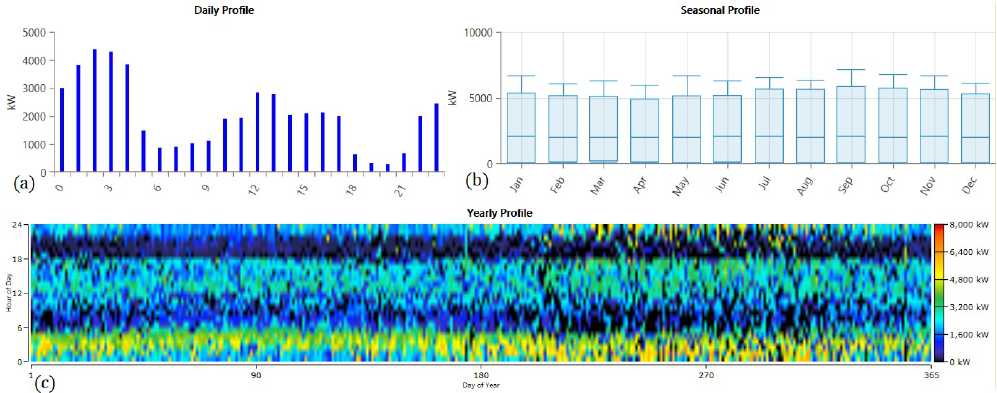
Figure 7. EV charging load with charging strategy: ( a ) box and whisker plot of monthly profiles; ( b ) annual load intensity plot; ( c ) example of a daily